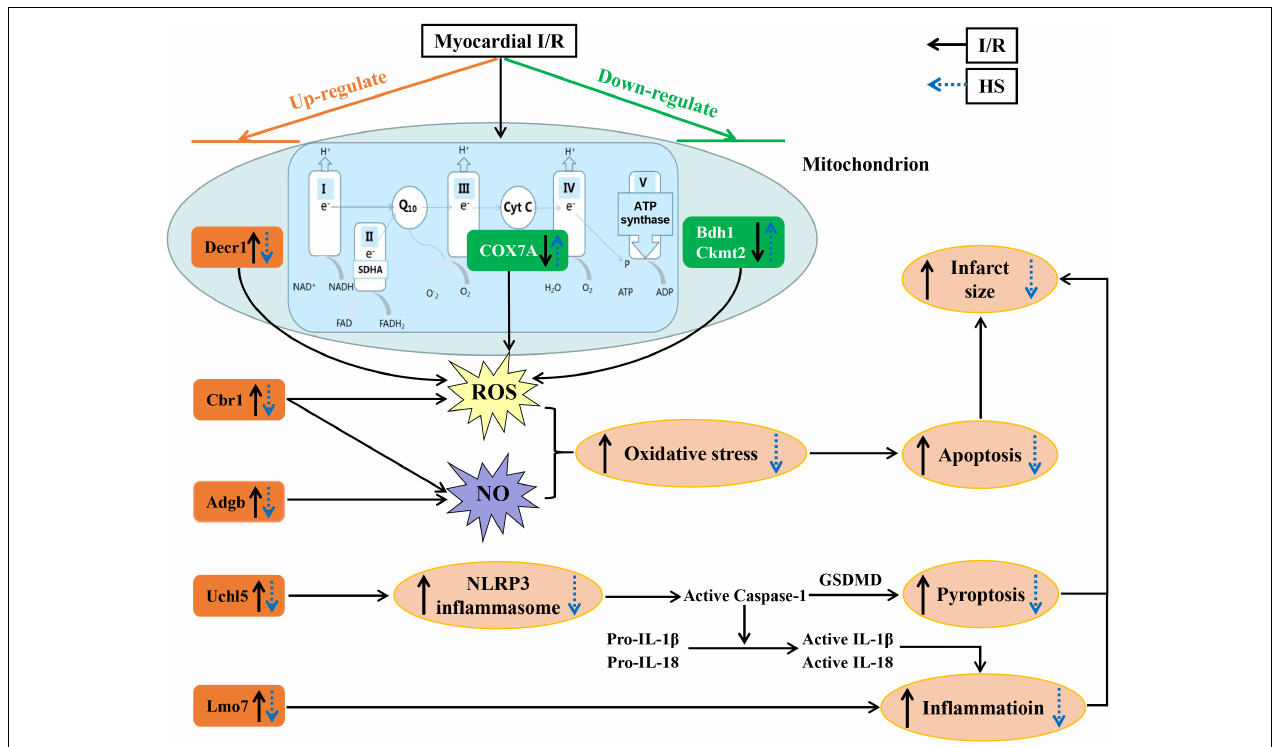
FIGURE 10 | A diagrammatic sketch displaying the pathways that lead to the protective effect of Herba Siegesbeckiae (HS) on Ischemia/Reperfusion (I/R)-induced cardiac injury. I/R upregulates the expression of Adgb, Cbr1, Decr1, Uchl5, and Lmo7, and downregulates the expression of Bdh1, Ckmt2, and COX7A, resulting in oxidative stress and NLRP3 inflammasome activation with enhancement of inflammation, pyroptosis, apoptosis, and infarct size. Nevertheless, HS pre-treatment reverses all the above alterations. The cardioprotective role of HS relies on the inhibition of oxidative stress and NLRP3 inflammasome, and the restoration of mitochondrial